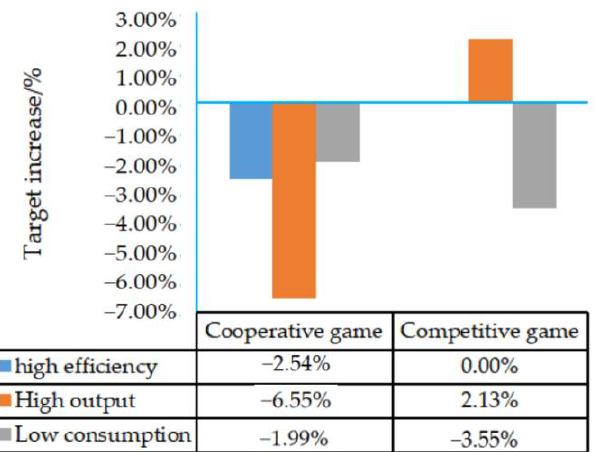
Figure 3. Target increase (%) obtained under cooperative and competitive game mechanisms ac- cording to the multi-objective optimisation.